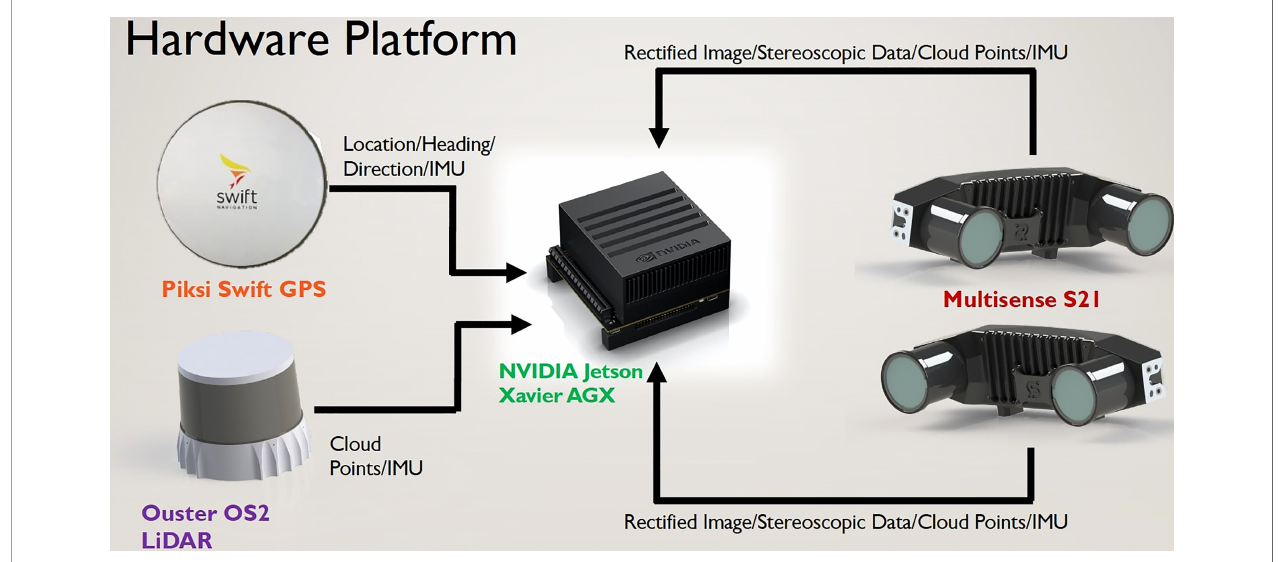
FIGURE 1 | Flow chart showing the sensors connected to the computing